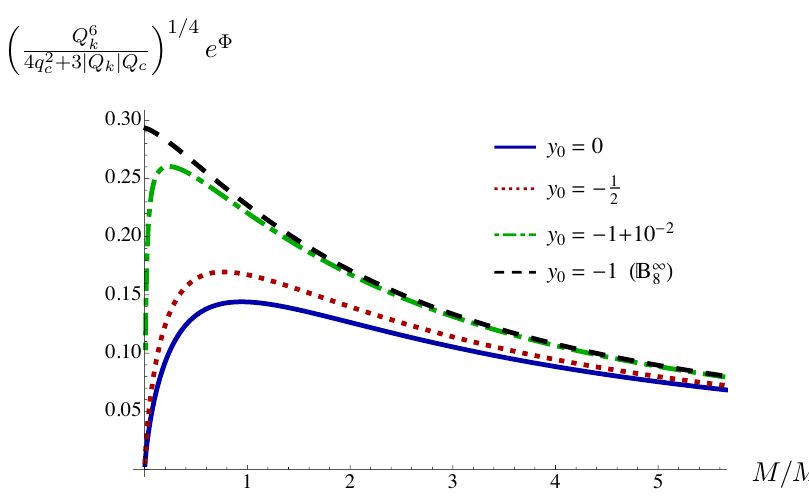
Figure 7 . Dilaton as a function of the energy scale for several B +